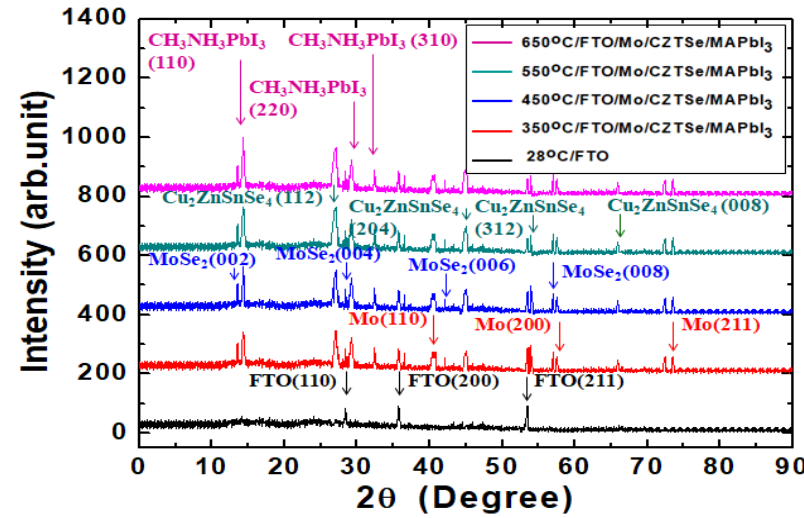
Figure 3. XRD di ff raction pattern results of the MAPbI 3 / Cu 2 ZnSnSe 4 / Mo / FTO nanostructures on glass Figure 3. XRD diffraction pattern results of the MAPbI 3 /Cu 2 ZnSnSe 4 /Mo/FTO nanostructures on substrate after the various annealing glass substrate after the various annealing temperatures.